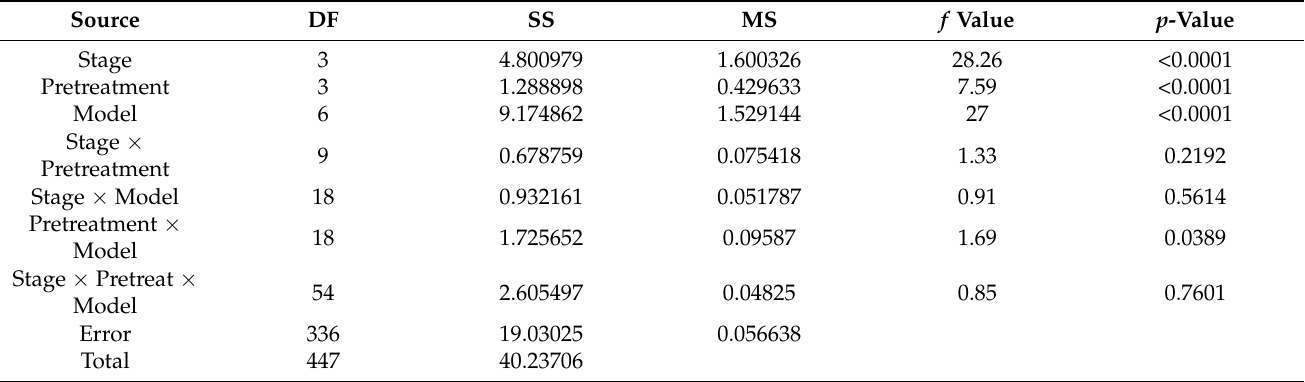
Table 3. Analysis of variance of percentage of correctly classified four B. juncea varieties from four different preprocessing methods and eight different classification models using reflectance